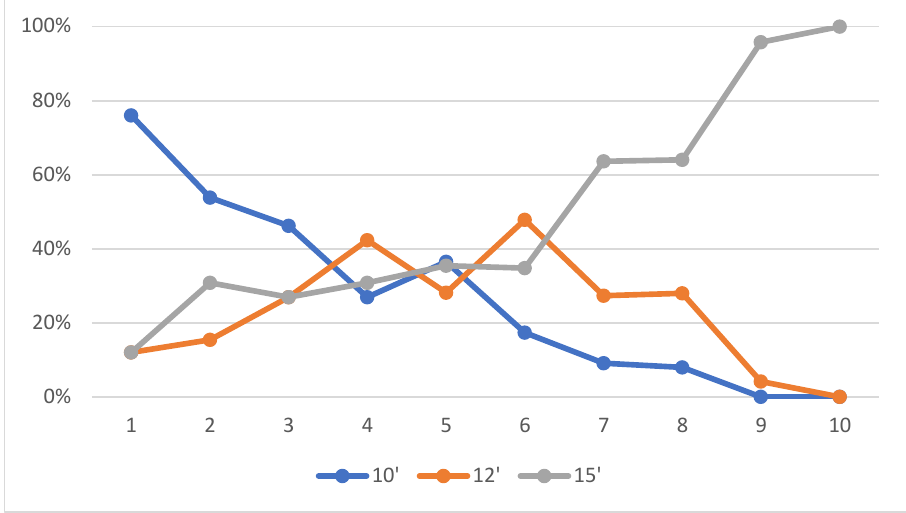
Figure 2. The distribution of selected run times in Test Group 1.